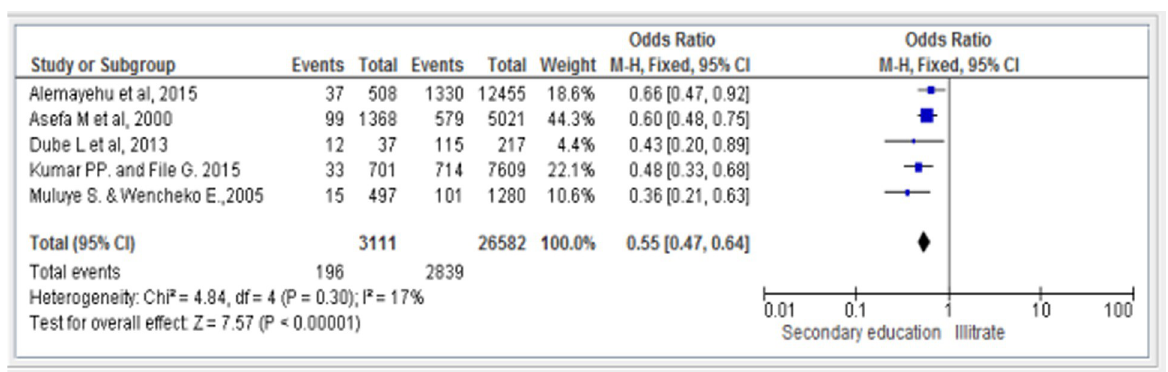
Fig 4. Forest plot of five studies to show the effect of secondary and above maternal education on infant mortality in Ethiopia.